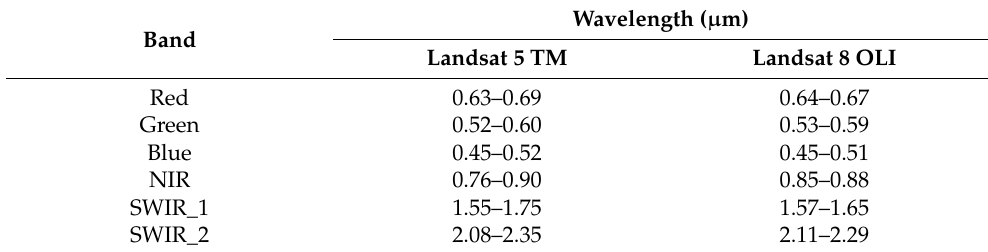
Table 4. Wavelengths of the selected bands of Landsat 5 TM and Landsat 8 OLI.